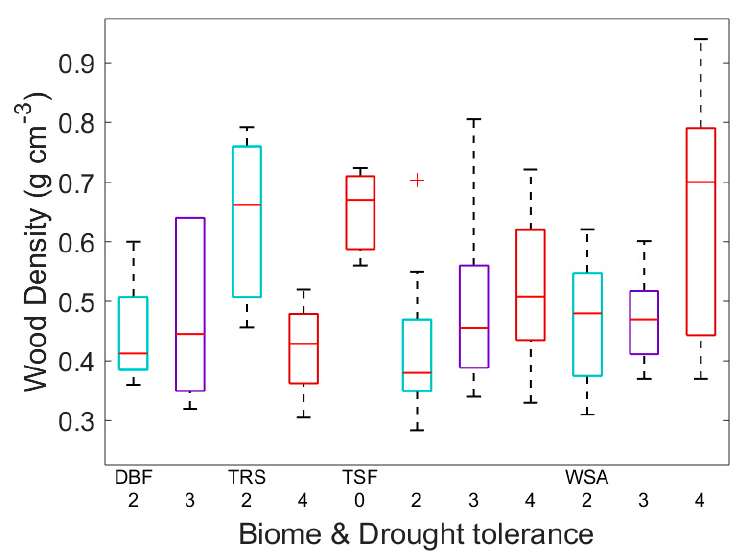
Figure 4. Drought tolerance generally increases with wood density. From left to right along the x-axis biomes are deciduous broadleaf forest (DBF), tropical-seasonal forest (TRS), temperate-seasonal forest (TSF), and woodland/shrubland (WSA). Missing bars are indicative of missing data for biome and drought tolerance. Drought tolerance is rated from 0 to 5 with 5 representing the most drought tolerant. Desert (DES) and tropical forests (TRO) are excluded from this figure because all species for each were listed as extremely drought tolerant (4) or extremely drought sensitive (0), respectively. Outlier values are marked with a red +.